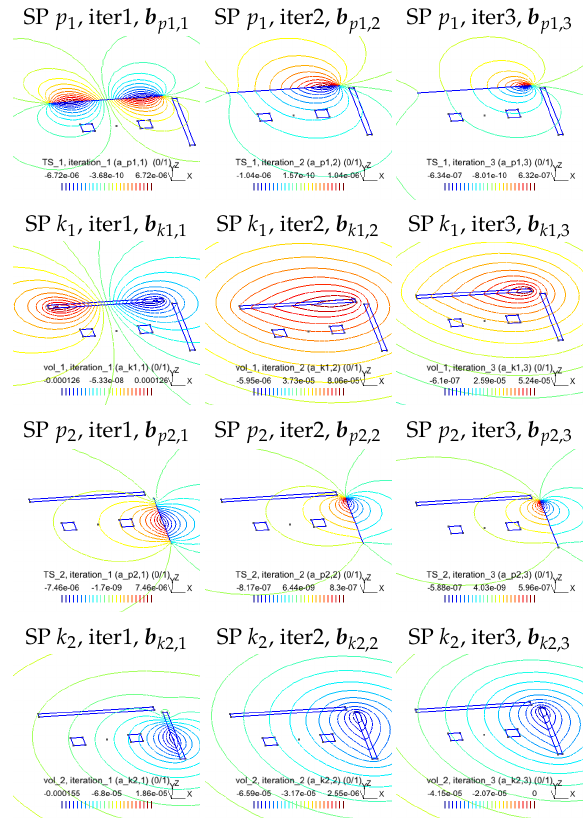
Fig. 3. The real part of magnetic vector potential ( a ) simulated in SP p 1 , SP k 1 , SP p 2 and SP k 2 , for several iterations (where SP p 1 is presented as the source